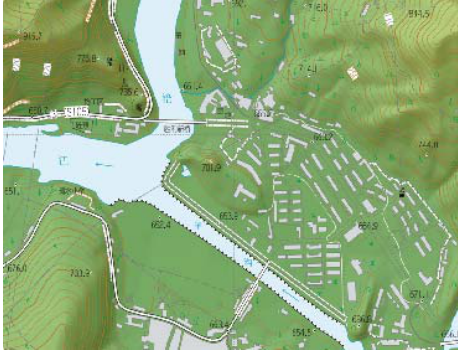
Figure 8. Map Product With DOM, DEM and